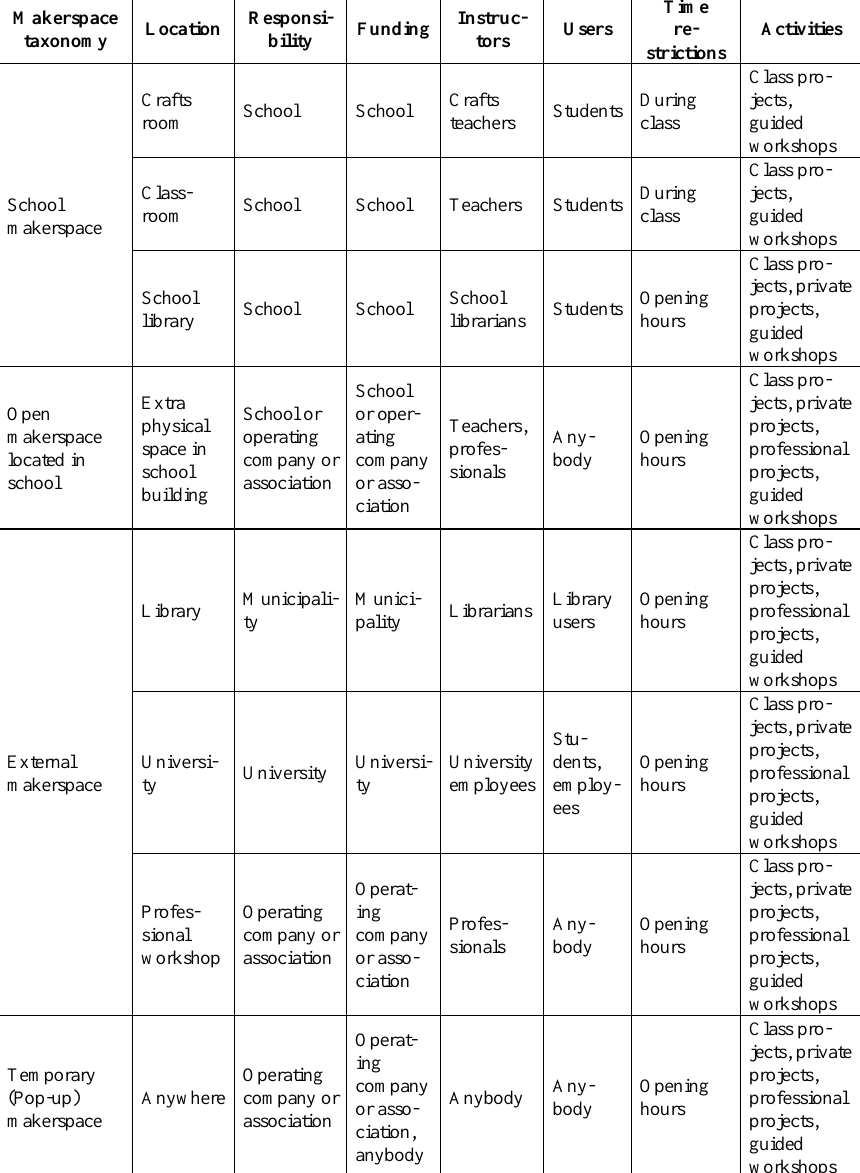
Table 1. Taxonomy concerning physical existing makerspaces in and used by schools Makerspace